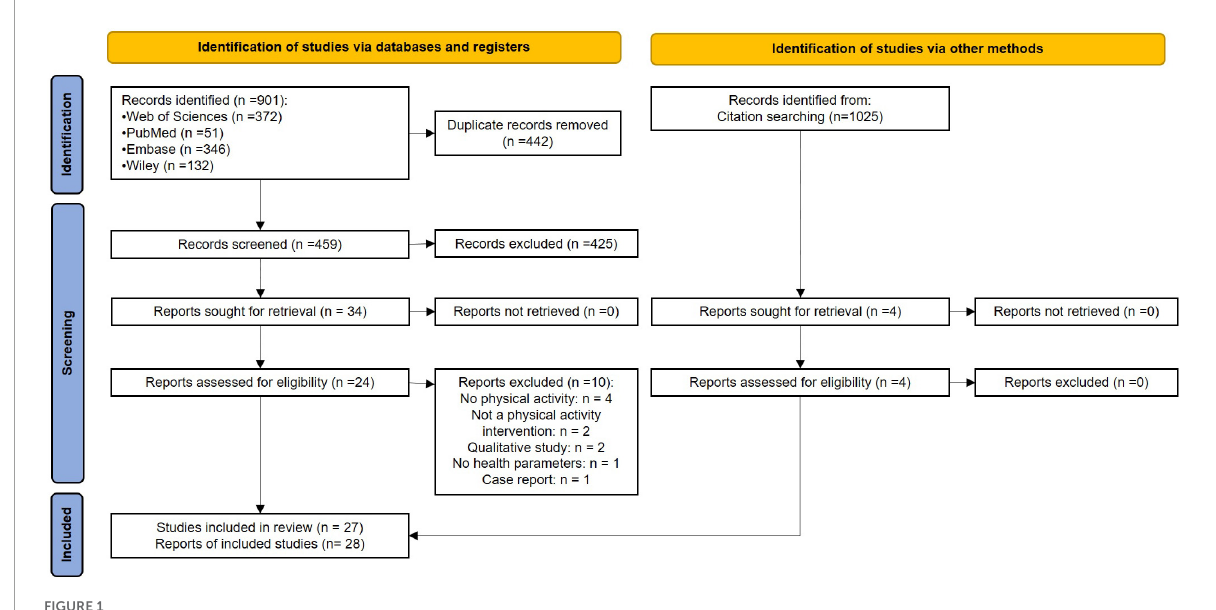
FIGURE1 PRISMA flow